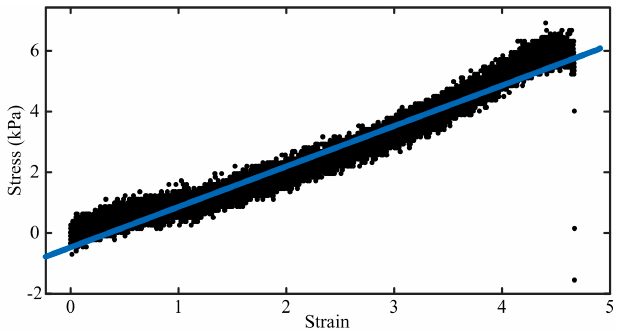
Figure 5. Tensile test results. Black dots represent individual data points; the blue straight line indicates the fitted line.